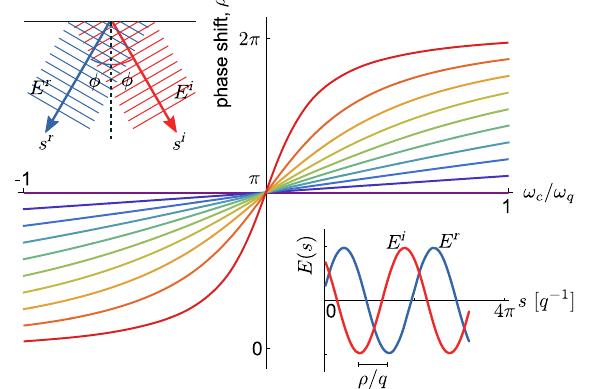
FIG. 2. Plasmon geometric phase. Phase shift between incident and reflected plane waves scattered off a boundary at different incident angles and relative magnetic field strength obtained from Eq. (11). While geometric phase shifts appear in both the current density and electric field, here we show the phase shift for (longitudinal) electric field along the directions − q i ( q r ) away from the interface. Lines from purple (closest to the x axis) to red (farthest away from the x axis) correspond to incident angles ϕ π = 2 Þð n= 10 Þ with n integers in the range n ∈ f 0 ; … ; 9 g . n ¼ ð Upper inset: Schematic for the incident and reflected plane wave. Lower inset: Electric field E i ( E r ) of the incident (reflected) plane wave exhibits a nontrivial shift ρ tunable by Hall conductivity (magnetic